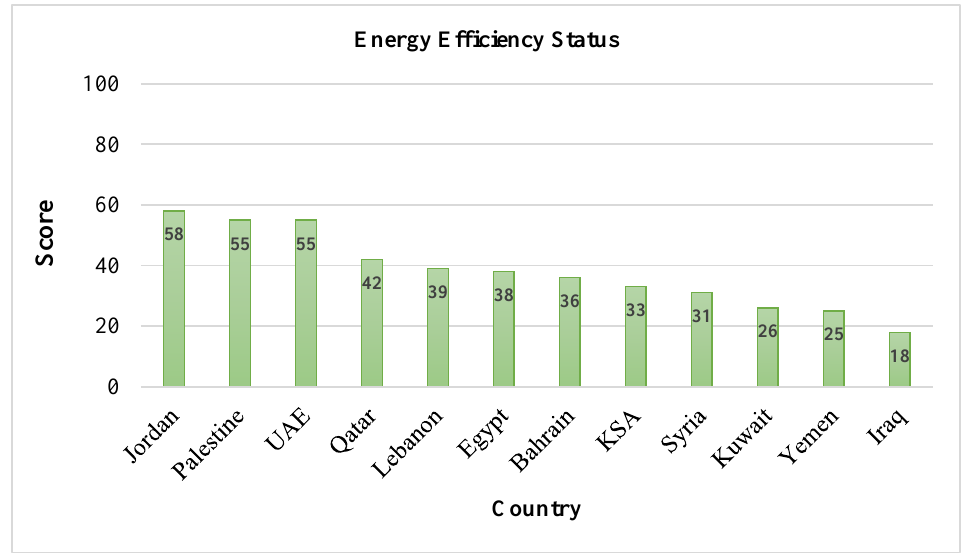
Figure 3. Energy E ffi ciency Status in the Middle East. The higher score indicates better energy e ffi ciency Figure 3. Energy Efficiency Status in the Middle East. The higher score indicates better energy status. The data is acquired from RCREEE efficiency status. The data is acquired from RCREEE [48].